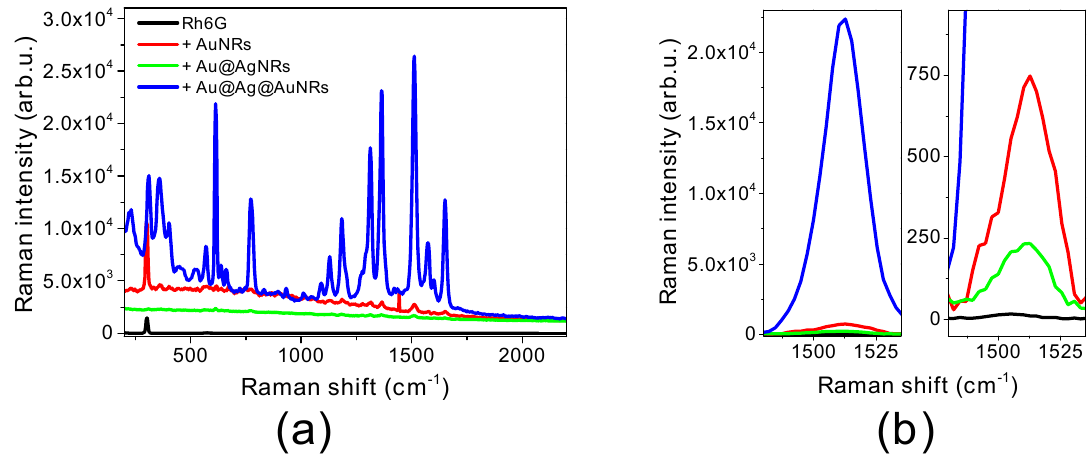
Figure 2. Raman spectra of 10 − 5 M Rhodamine 6G (Rh6G): ( a ) Raman spectra in aqueous solution (black line) and in the presence of AuNRs (red line), Au@AgNRs (green line) and Au@Ag@AuNRs (blue line); ( b ) magnifications of Raman peaks at 1510 cm − 1 (spectra have been translated for a better comparison). Rh6G structure is reported as inset in graph ( a ). Table 2. Analytical enhancement factors (calculated based on Raman peak at 1510 cm − 1 ) for Rh6G in the presence of AuNRs, Au@AgNRs and Au@Ag@AuNRs.